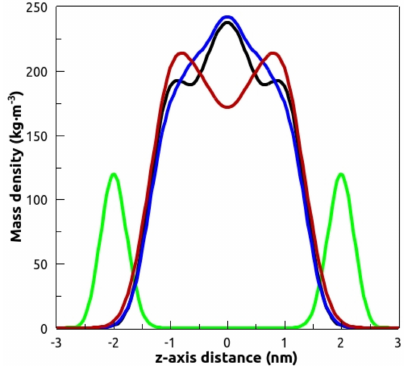
Figure 8. Mass density profiles along the zaxis of the simulation box of the simulated systems: POPC/TMX (phosphorus atoms in green and TMX in black), POPC/POPE/TMX (TMX in blue), and POPC/POPG/TMX (TMX in red). Curves are symmetrized around the center of the